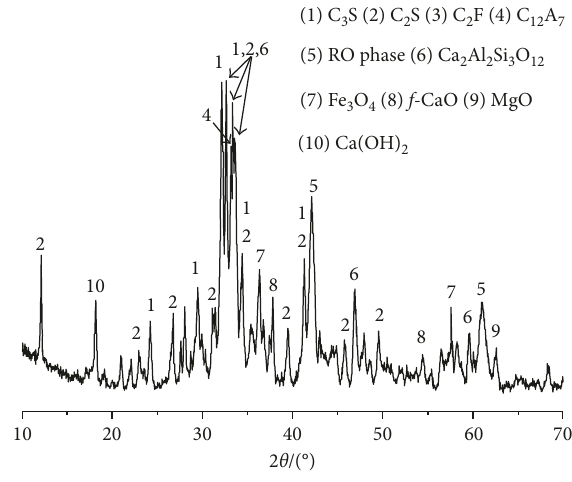
Figure 2: XRD patterns of the steel